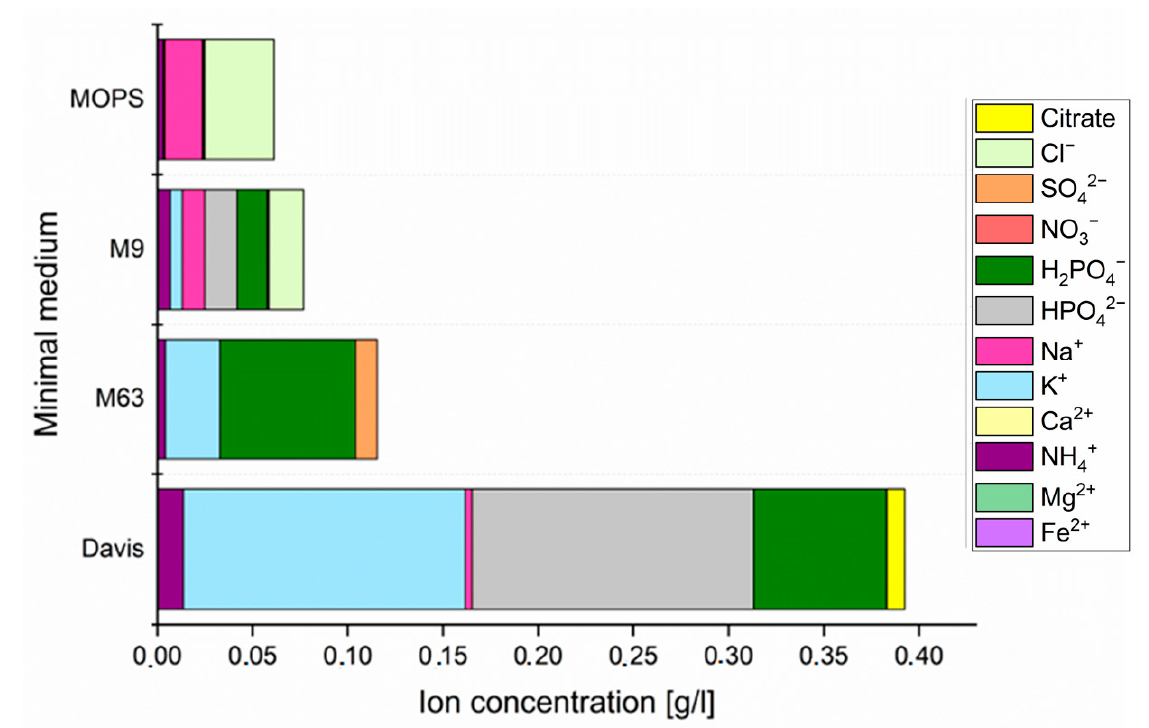
Figure 2. Concentration (g/L) of ions in minimal media used for antibacterial metal activity testing.